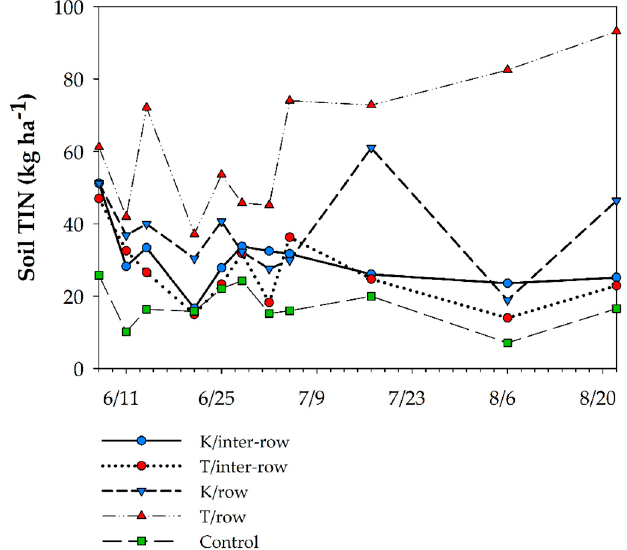
Figure A3. Soil TIN concentration following row establishment as a function of banded herbicide (K) and zone tillage (T) row management and with unmanaged clover (Control).